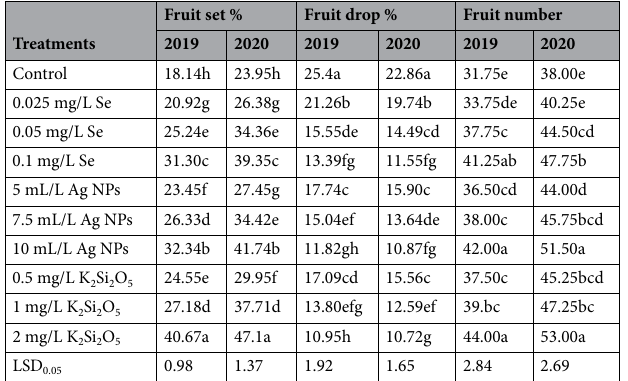
Table 3. Influence of the foliar spraying of Se, Ag NP S and K 2 Si 2 O 5 on the percentages of fruit set, and fruit drop as well as fruit number of “Succary” pomegranate cultivar 2019 and 2020 seasons. Means not sharing the same letter(s) within each column are significantly different according to LSD at 0.05 level of significance.